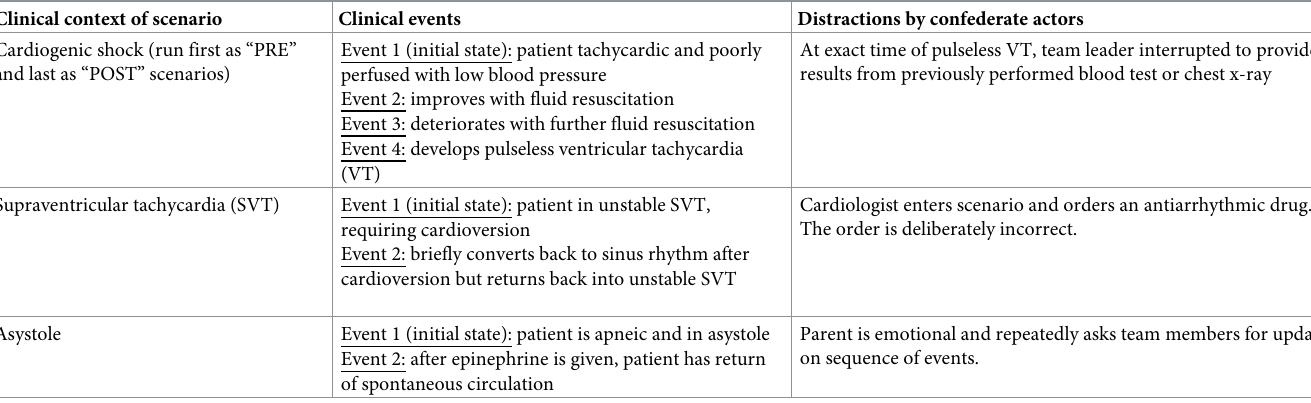
Table 4. Sequence of events in resuscitation scenarios and event